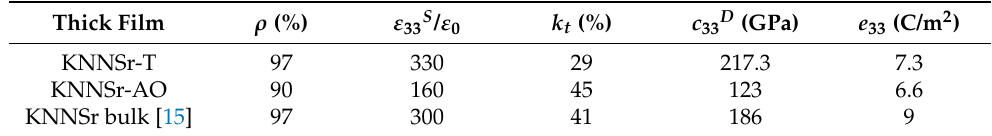
Table 2. Electromechanical properties of KNNSr-T and in KNNSr-AO. The literature data on KNNSr bulk are given for comparison.